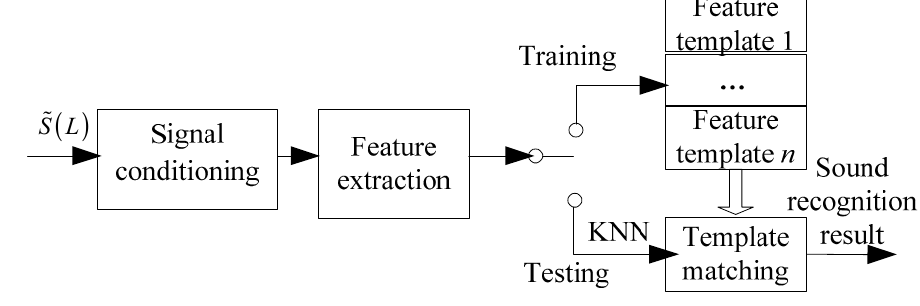
Figure 6. Functional architecture of template matching.